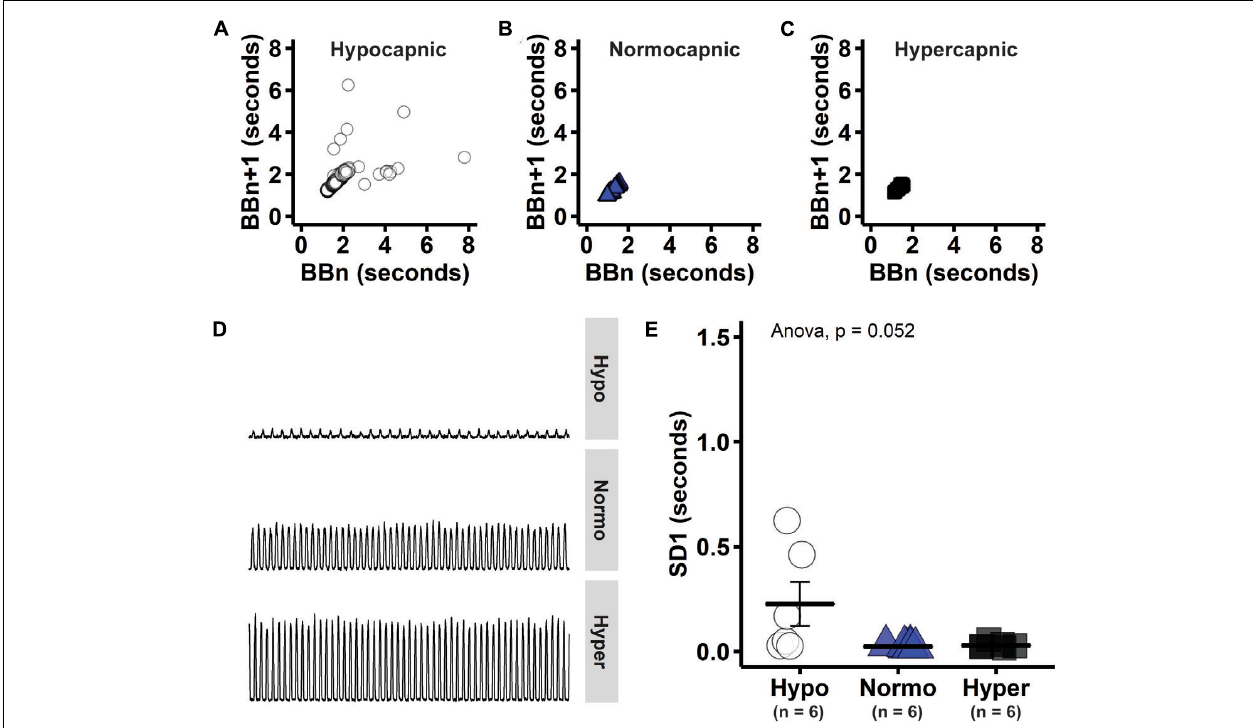
FIGURE 3 | Consecutive phrenic burst intervals tended to be more variable in hypocapnic group, consistent with unstable breathing that is expected near CO 2 apneic threshold. (A–C) Consecutive phrenic burst intervals (i.e., BBn versus BBn + 1) in hypocapnic, normocapnic and hypercapnic group, respectively. (D) Group-representative baseline phrenic activity. (E) Measure of Poincaré length that indicates long-term variability